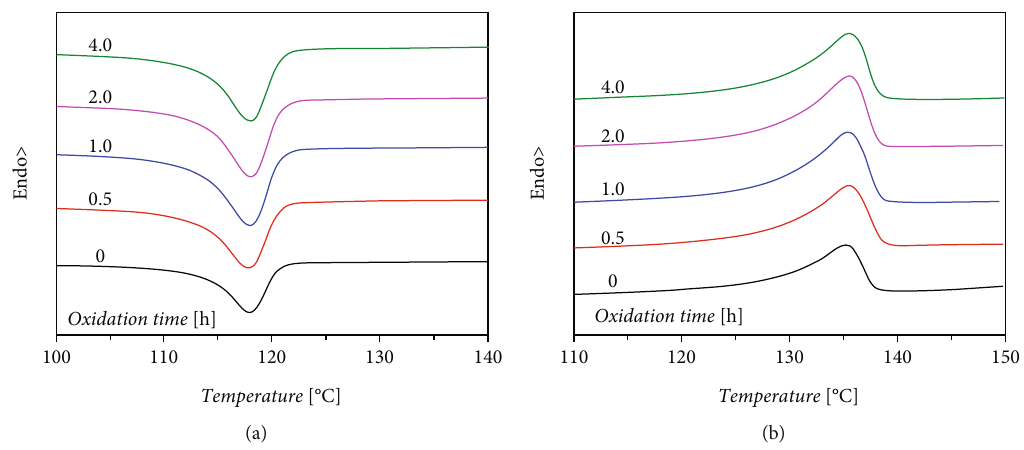
Figure 4: The DSC curves of unoxidized and oxidized